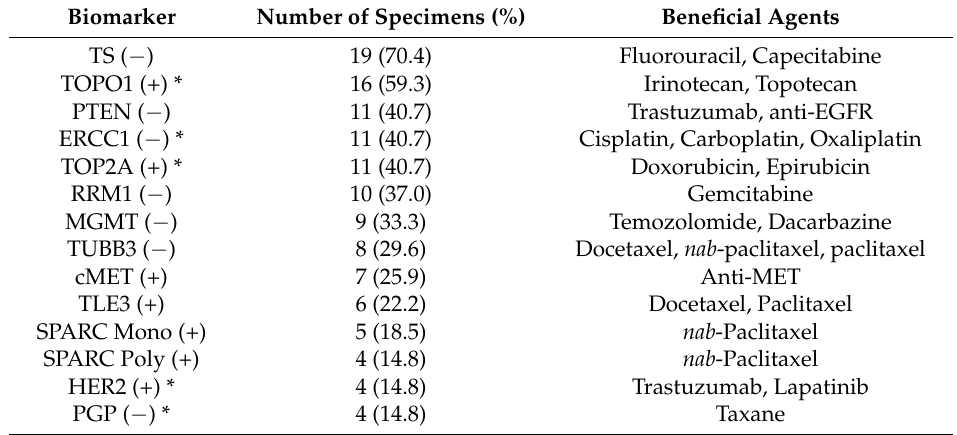
Table 4. Frequency of actionable targets tested by immunohistochemistry along with the associated therapeutic